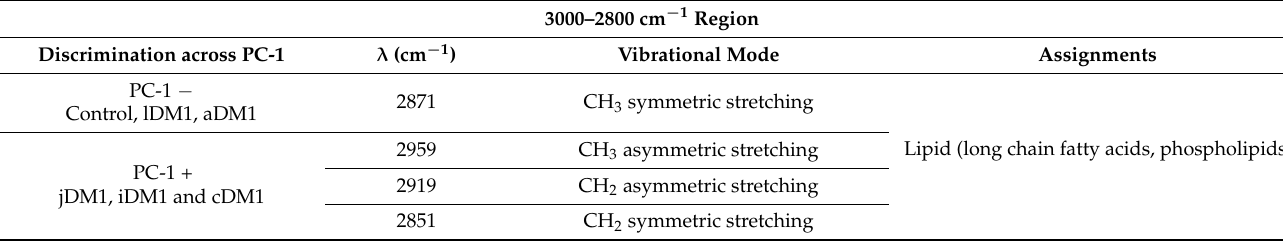
Table 2. Neurolab UA DM1-derived fibroblast and control spectroscopic signals, assignments and vibrational mode obtained by PCA in the 3000–2800 cm − 1 , 1800–1500 cm − 1 and 1200–900 cm − 1 regions. λ —Wavenumber Q—Quadrant; − —Negative quadrants; +—Positive quadrants; DM1—derived fibroblast; lDM1—late-onset; aDM1—adult-onset; jDM1—juvenile-onset; iDM1—infantile-onset;